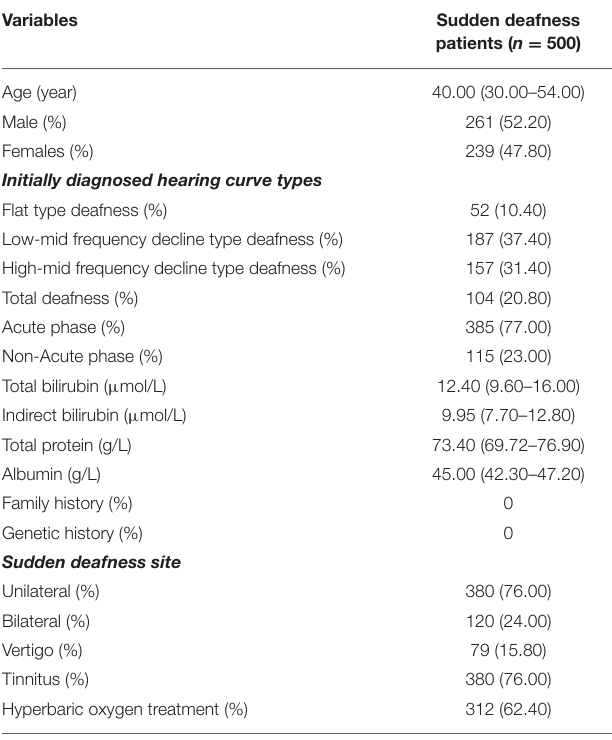
TABLE 1 | Clinical characteristics of enrolled patients with sudden deafness.